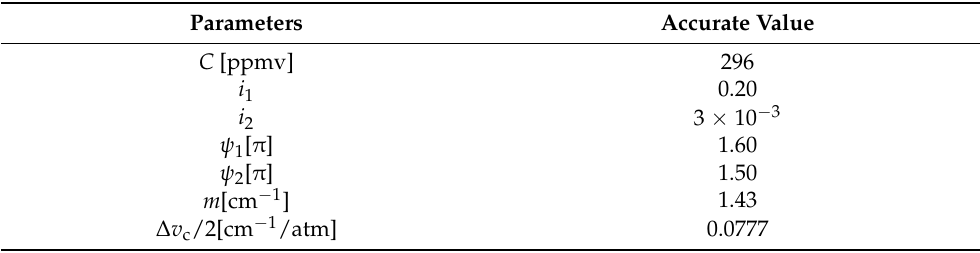
Table 1. List of model parameters.